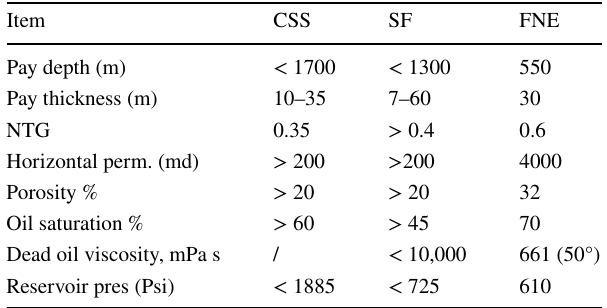
Table 2 Screening criteria for thermal recovery and development (Elbaloula et al. 2016)